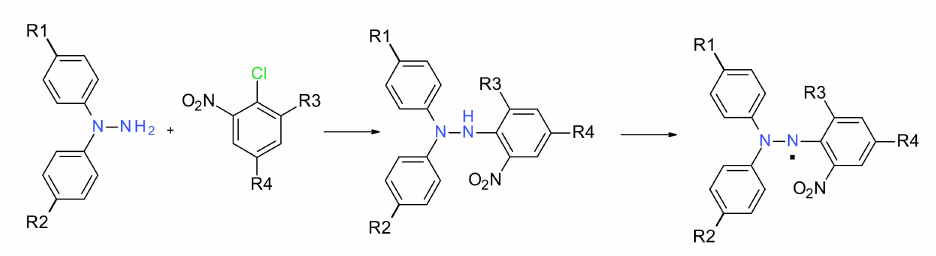
Figure 5. Typical synthesis of hydrazyl free radicals.